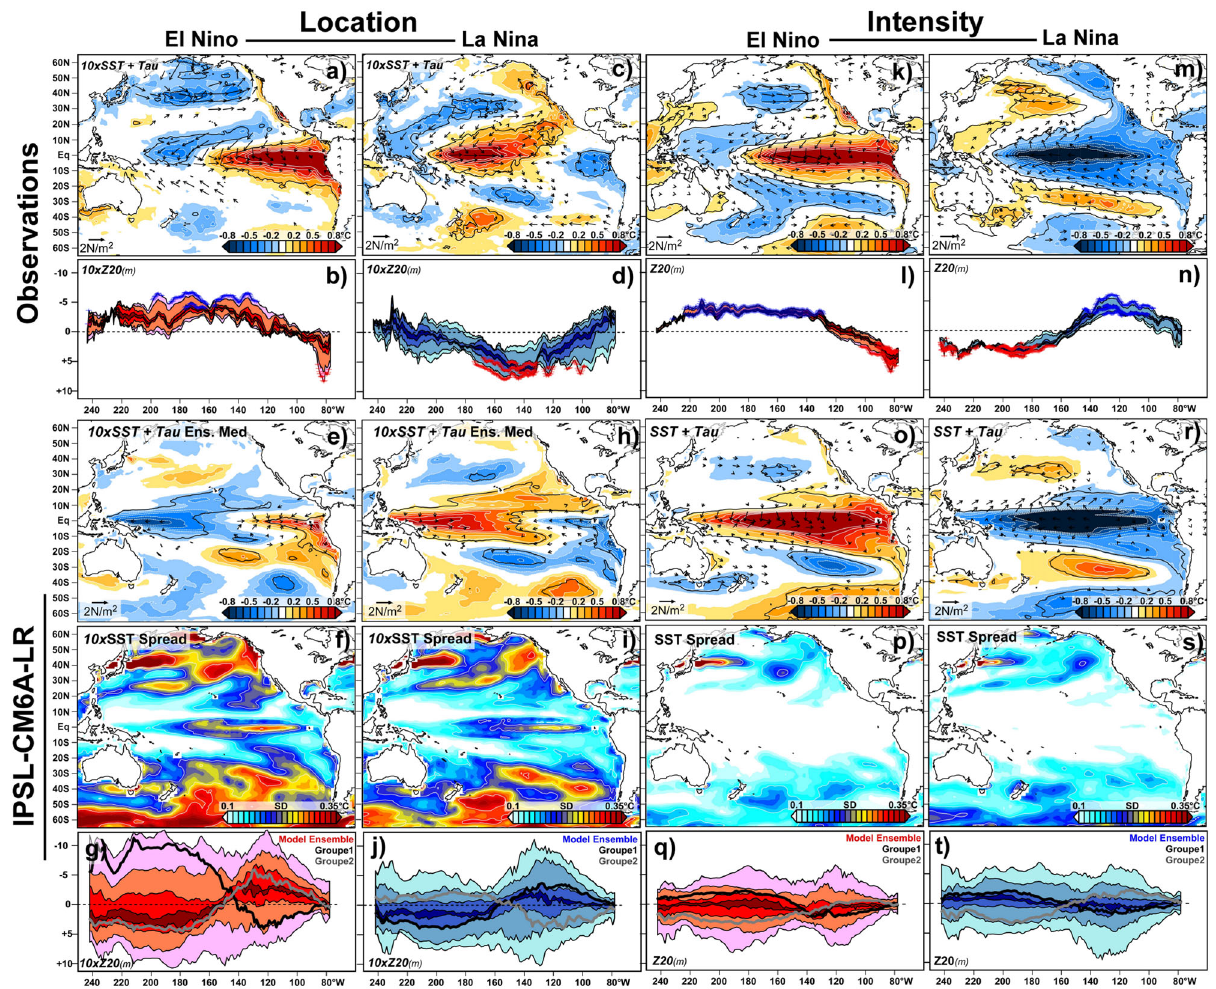
Fig. 6 Large-scale patterns driving long-term variability in ENSO location and intensity. a Regressed SST (blue-to-red shades) and wind-stress (vectors) anomalies associated with changes in El Niño location using multiple observational datasets (SST: ERSST.v5, COBESST.v2, HadSST1, SODA.si3, CERA20C; wind stress: NOAA-20CR.v3; Z20: SODA.v2.2.4). b Same as ( a ) but for Z20 anomalies. c , d Same as ( a , b ) but for La Niña events. e – j same as ( a – d ) but using the IPSL-CM6A-LR large ensemble (32 members). k – t Same as ( a – j ) but for El Niño and La Niña intensity. While SST and wind-stress anomalies are displayed at the pan-Paci fi c scale based on the median changes in ( a , c , k , m ) observations, simulated regressed anomalies are assessed through ( e , h , o , r ) the ensemble median and ( f , i , p , s ) ensemble spread (standard deviation [SD]). Z20 anomalies are estimated through the median changes between 5°S and 5°N ( b , d , l , n , g , j , q , t ). Red and blue shades on the Z20 anomalies indicate the spread between the four SST observational datasets and within the IPSL-CM6A-LR large ensemble (light to dark: maximum/minimum, 10/90 th , 30/70 th , and 45/55 th percentiles), for El Niño and La Niña, respectively. Group 1 (black lines) and Group 2 (grey lines) illustrate how two opposed types of equatorial Z20 anomalies in fl uence the ensemble spread. Statistical signi fi cance is assessed at p = 0.05 using 1000 permutations, and displayed as black contour for SSTa, and blue/red crosses for Z20 anomalies. Only signi fi cant wind-stress anomalies at p = 0.05 are